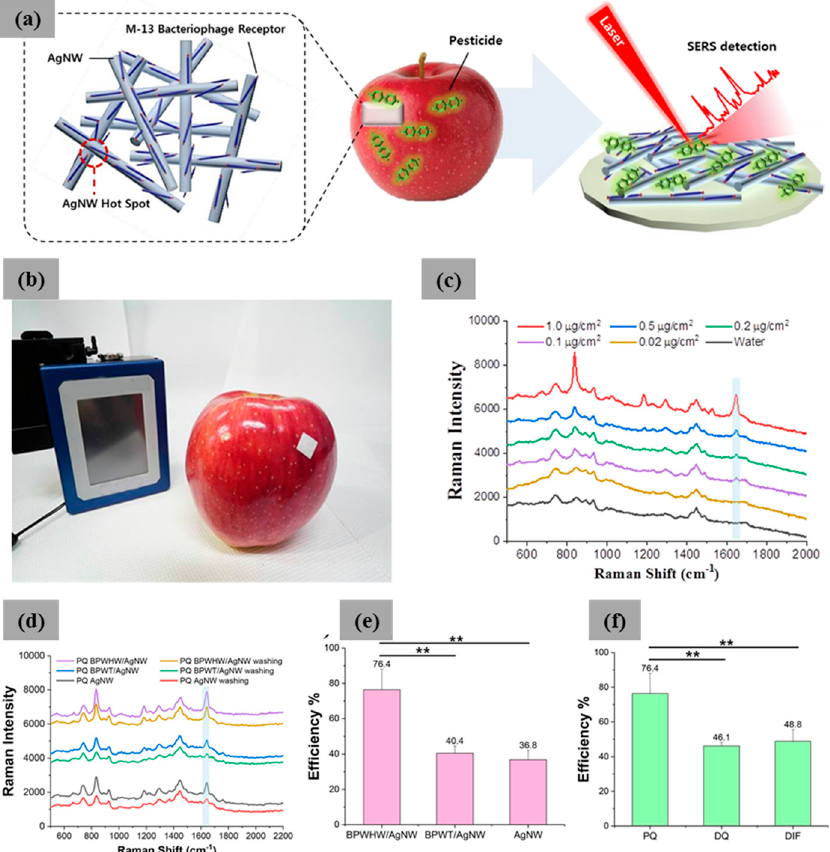
Figure 9. ( a ) Illustration of surface-enhanced Raman spectroscopy (SERS) by a functionalized